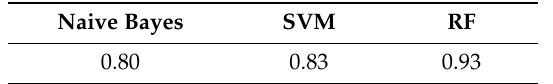
Table 3. AUC values resulting from the three classification models.